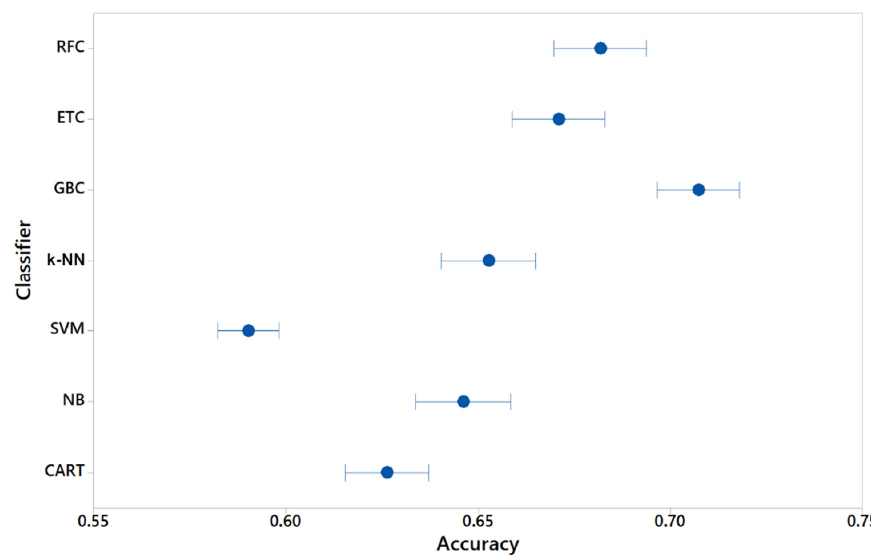
Figure 3. Interval plot of accuracy for all the classifiers (95% confidence interval of the mean). Overlapping between pairs of intervals means that there are no statistical differences.